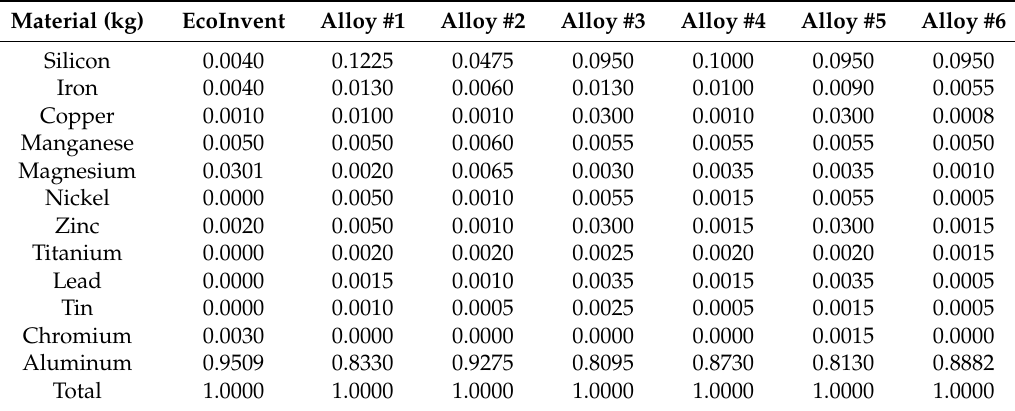
Table 4. Balanced material composition for 1 kg of aluminum alloy.